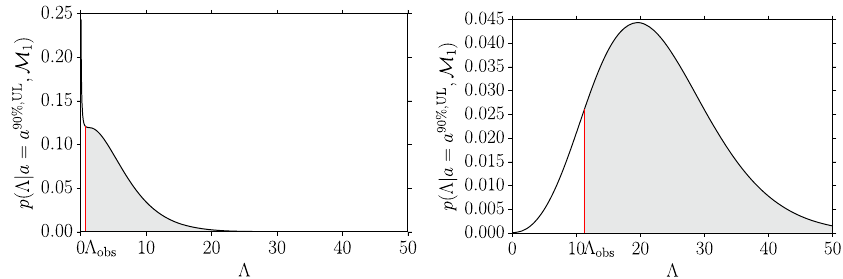
Fig. 14 Probability distributions for the frequentist detection statistic Λ , conditioned on the value of the amplitude a for which the probability of obtaining Λ ≥ Λ obs is equal to 0.90. These define the 90% confidence-level frequentist upper limits a 90% , UL = 0 . 20 and 0.46, respectively. The red vertical lines mark the value of Λ obs for the weak ( left panel , Λ obs = 0 . 72) and strong ( right panel , Λ obs = 11 . 2) injections